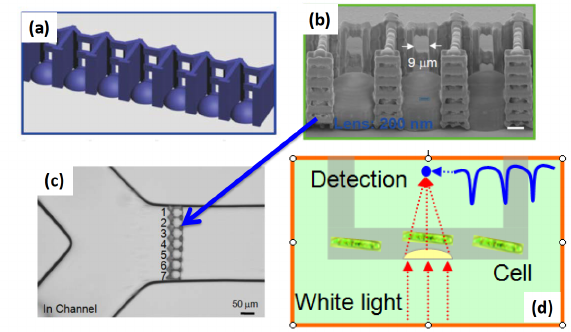
Figure 16: (a) Schematic illustration and (b) SEM image of a mi- crolens array combined with center-pass units formed by TPP. (c) Optical microscope image of 3D glass microfluidic integrated with the microlens array combined with center-pass units. (d) Principle of cell detection with the fabricated optofluidics device